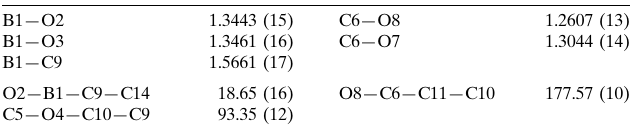
Selected geometric parameters (A˚ , (cid:2) ).